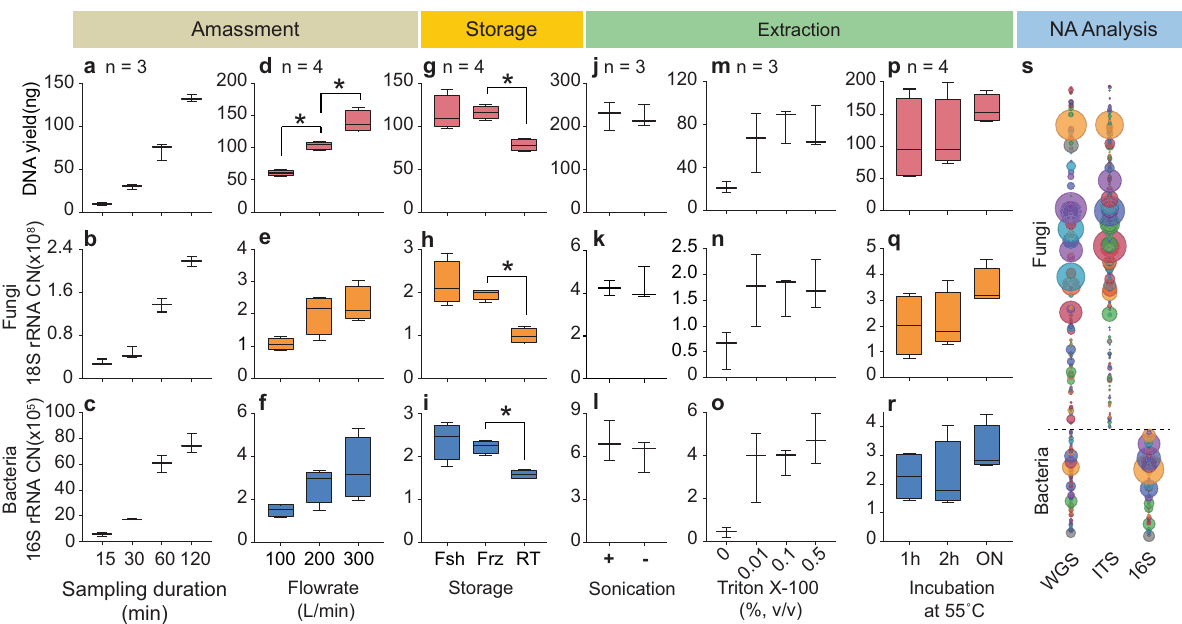
Fig. 2 Summary of quantitative analysis with DNA yield, 18S copy number (CN) and 16S copy number (CN). a – c Assessment of air sampling duration from 15 min to 3 h. d – f Assessment of air sampling fl ow rate from 100 L/min to 300 L/min. g – i The integrity of sampled biomass when processed fresh (Fsh), stored in freezer for 5 d (Frz) or stored at room temperature for 5 d (RT). j – l Impact of sonication on DNA yield. ( m – o ) Impact of detergent addition at different concentrations (0.01 – 0.5% v/v) during fi lter sample wash. p – r Impact of extended pre- incubation (1 h to overnight) at 55 °C during DNA extraction. The centre line, bound of box and whiskers represent median, 25th – 75th percentile and min-to-max values, respectively. s Whole-genome shotgun (WGS) and amplicon (ITS/16S) sequencing approaches. * denotes statistical signi fi cance ( p < 0.05) tested with Mann – Whitney